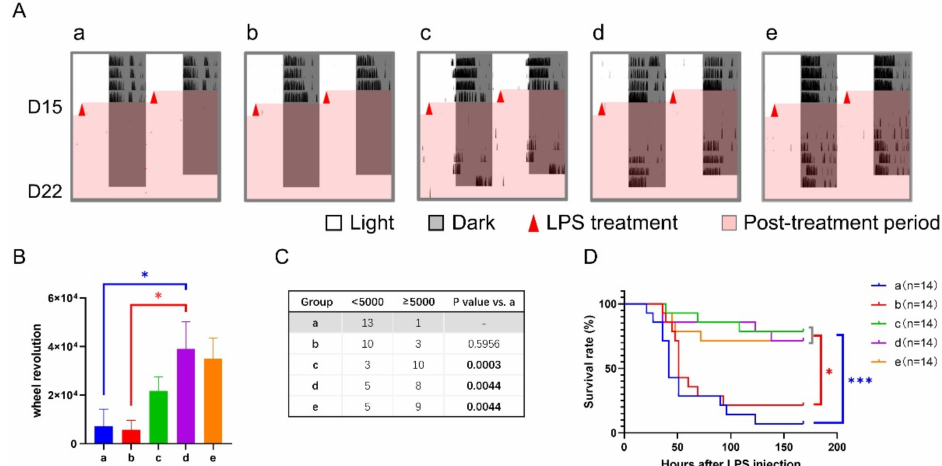
Figure 3. Effect of 6-h TRFs on behavior and health in mice treated with a 6-h delay phase shift and LPS injection. ( A ) Representative double-plotted actograms of wheel running activity after LPS treatment. ( B ) Total number of wheel revolutions after LPS injection. * p < 0.05, one-way ANOVA with Tukey’s multiple comparisons test. ( C ) The numbers of active and inactive mice after LPS treatment, Chi-square (and Fisher’s exact) test. ( D ) Effect of TRF on the survival of septic mice. *** p < 0.001, * p < 0.05, Log-rank